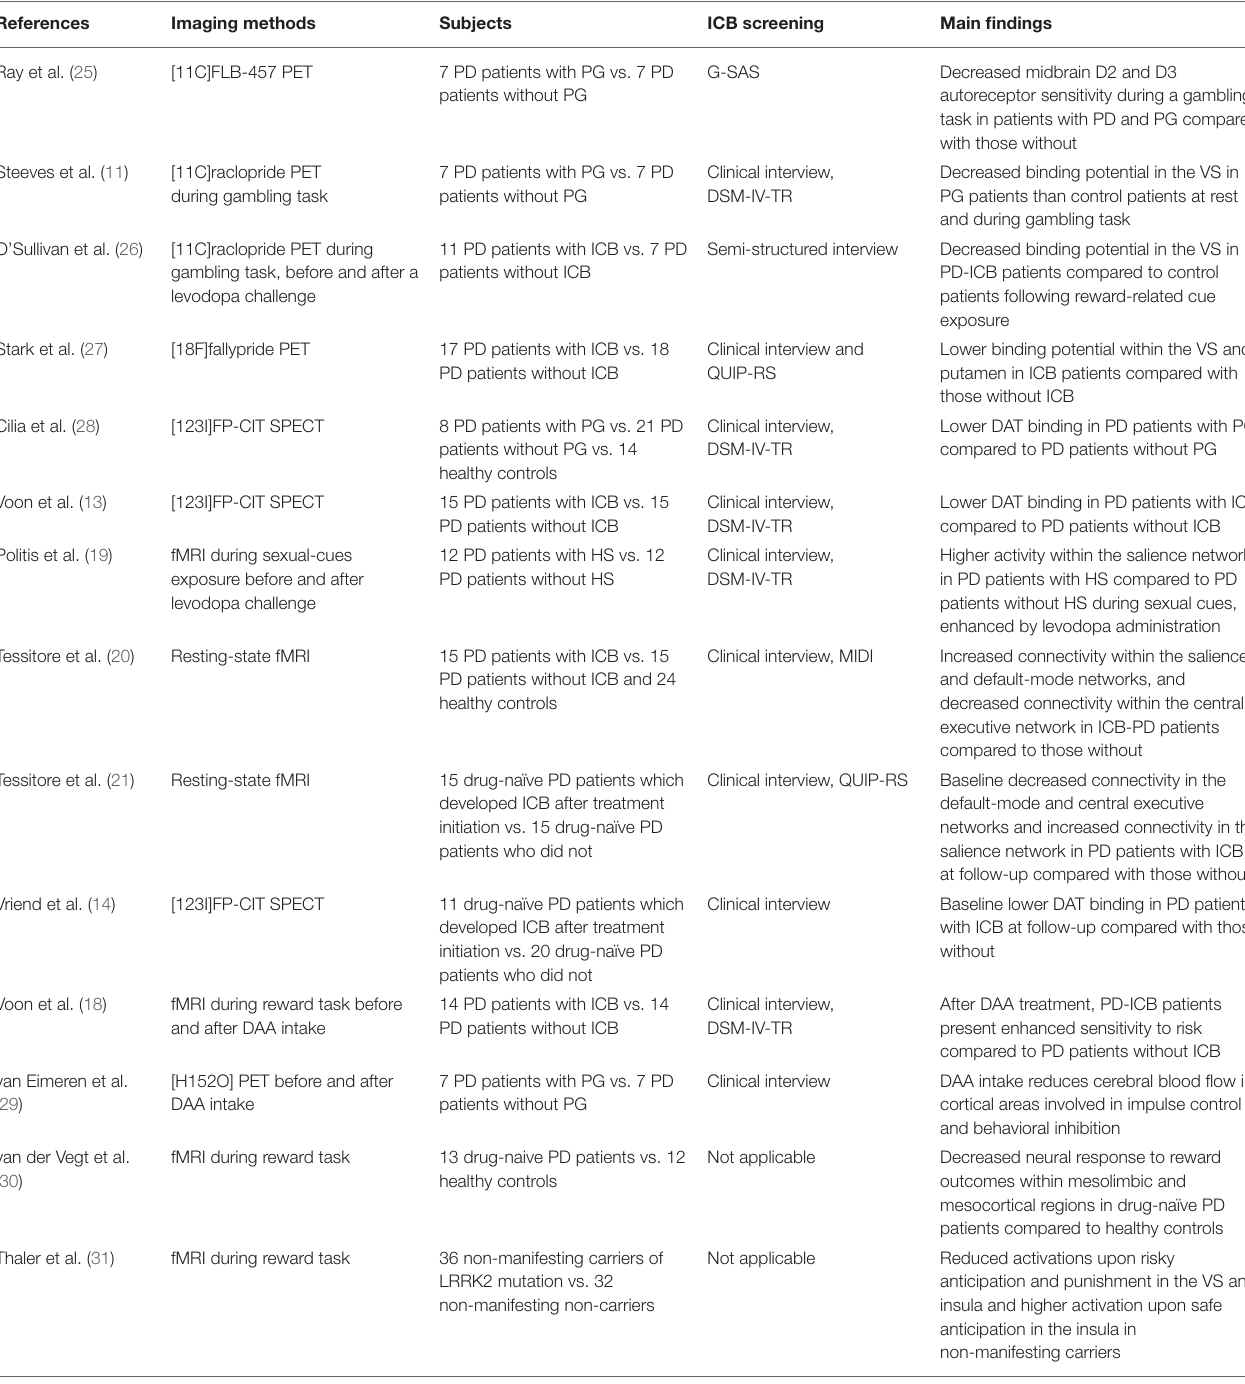
TABLE 1 | Summary of the methods and results from the studies included in the